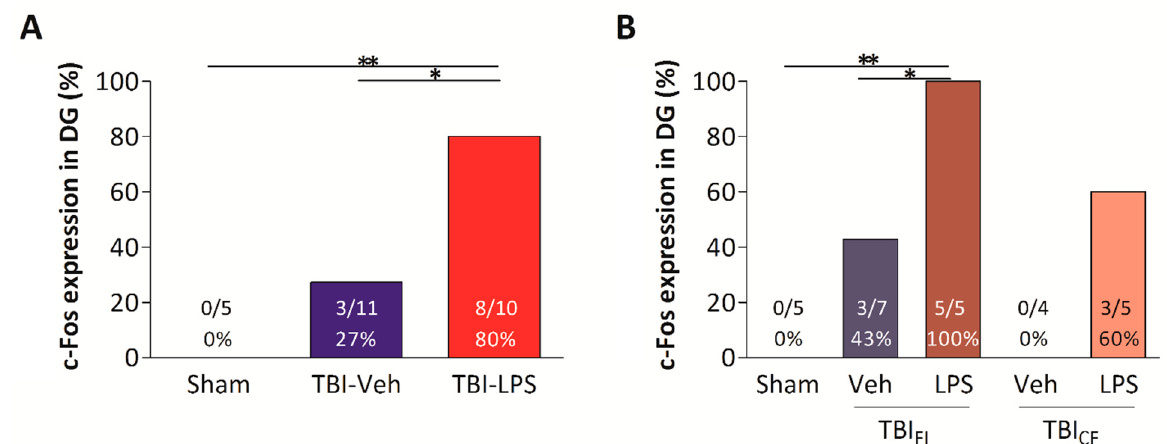
Figure 11. c-Fos expression in the dentate gyrus (DG). ( A ) Percentage of animals with increased c-Fos expression in the dentate gyrus was higher in the TBI-LPS than in the TBI-Veh and Sham-Veh groups. ( B ) All rats in the TBI FI -LPS group more commonly showed increased c-Fos activation in the dentate gyrus than rats in the TBI FI -Veh and Sham-Veh groups. Abbreviations: CF, cavity-forming; DG, dentate gyrus; FI, focal inflammatory; LPS, lipopolysaccharide; TBI, traumatic brain injury; Veh, vehicle. Statistical significances: * p < 0.05, ** p < 0.01 ( χ 2 -test).